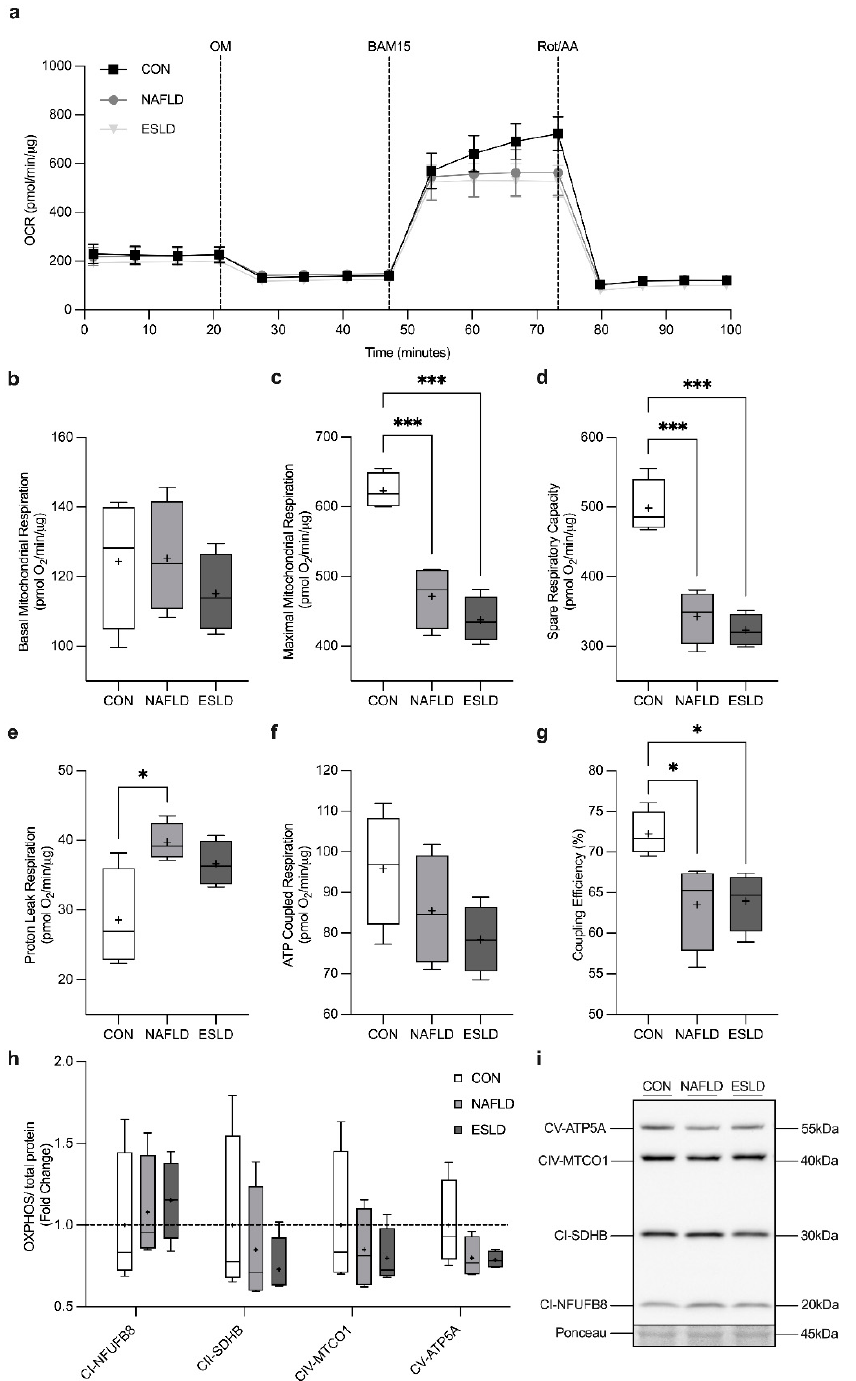
Figure 4. Serum from NAFLD and ESLD patients induces impairments in mitochondrial respiration, despite no changes in markers of mitochondrial protein content. ( a ) Raw trace of oxygen consumption rate (OCR) for myotubes treated with ex vivo serum from non-alcoholic fatty liver disease (NAFLD), end stage liver disease (ESLD) and age-matched controls (CON), ( b ) basal mitochondrial respiration was assessed prior to the addition of oligomycin (OM), an ATP synthase inhibitor and represents the energetic demand of the cell in baseline conditions, ( c ) maximal mitochondrial respiration was calculated after the addition of the uncoupler BAM-15, ( d ) spare respiratory capacity indicates the ability of a cell to respond to an increase in energetic demand ( e ) proton leak respira- tion represents the portion of basal respiration not associated with ATP production ( f ) ATP coupled respiration was calculated upon the addition of OM, ( g ) coupling efficiency was calculated as the